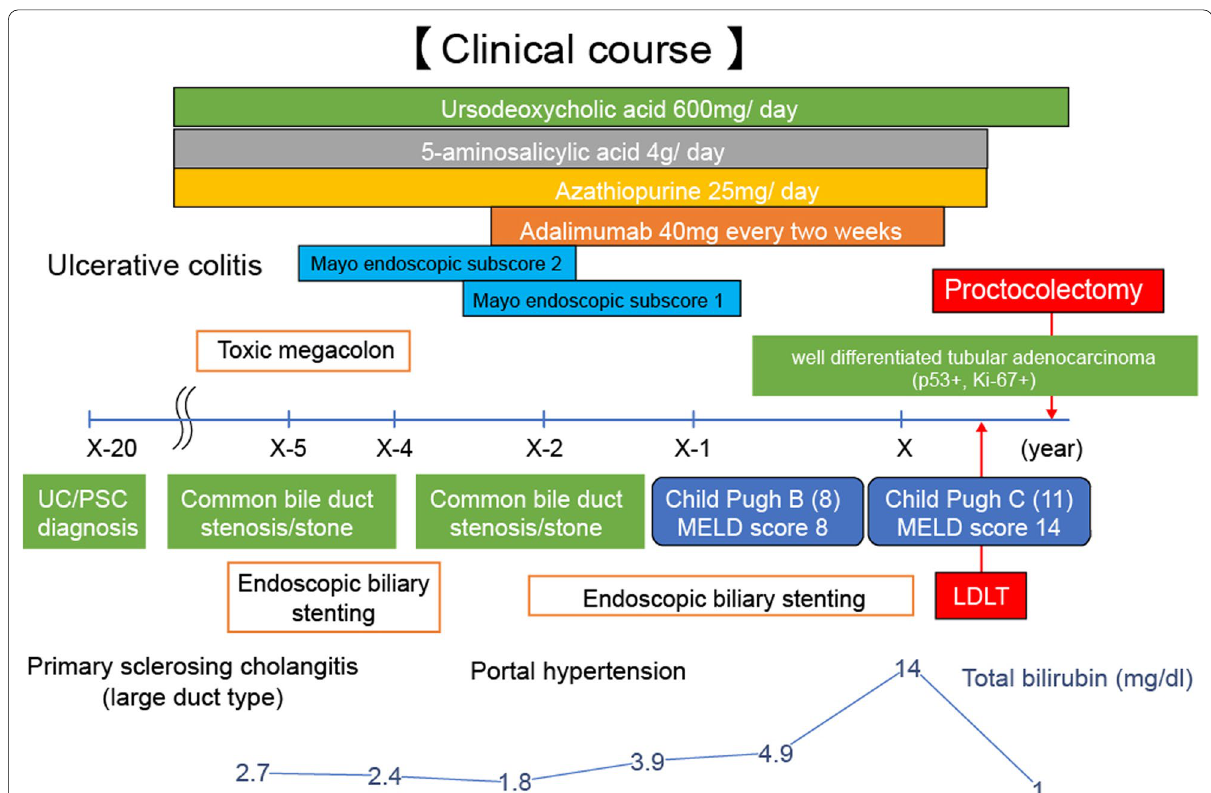
Fig. 4 Clinical course of the patient since PSC and UC were